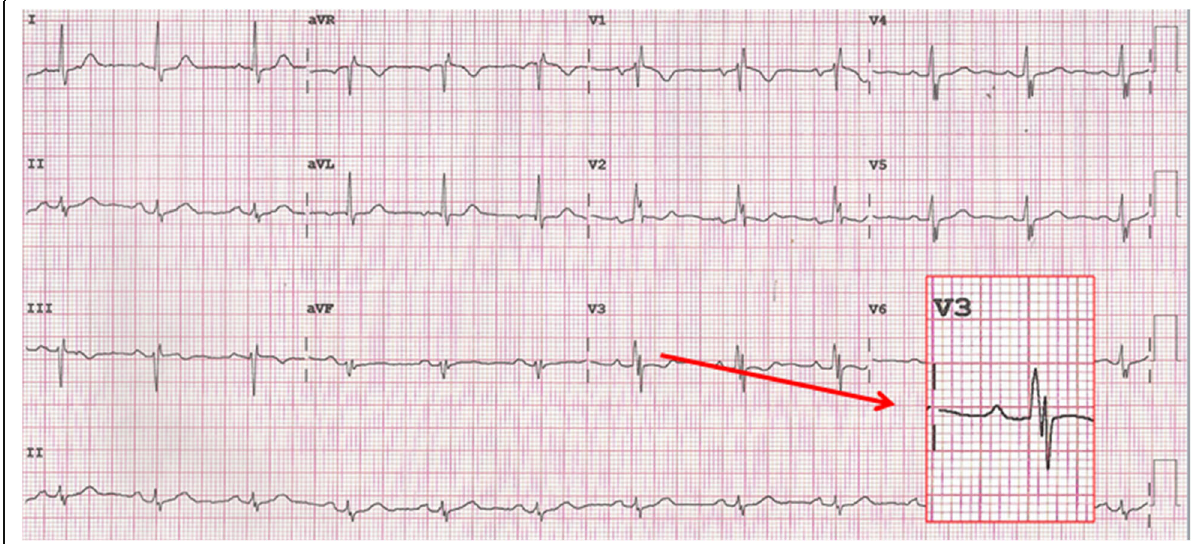
Fig. 1 Twelve-lead surface ECG recording for one of our study population showing different patterns of QRS fragmentation in inferior, anterior, and lateral leads (R ’ in V 1 , notched R wave in V 2 , notched S wave in II and V 4 – 6 ). This patient was discovered to have CAE in LAD, LCX, and RCA by invasive CA. A magnified view of lead V 3 is shown with 2 positive and 2 negative waves with a normal QRS complex